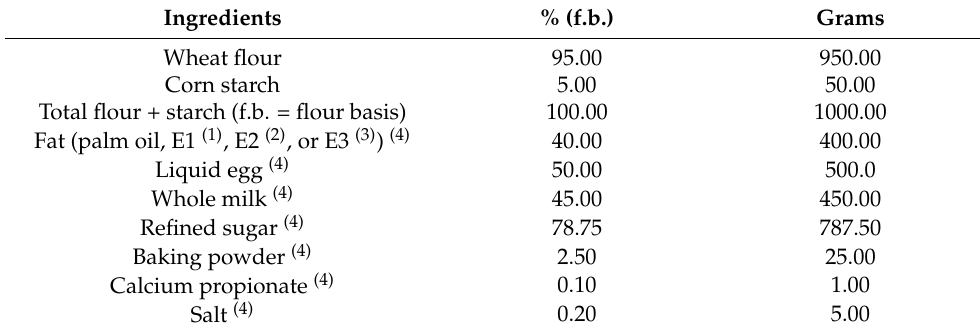
Table 1. Formulation used to prepare the pound cakes.